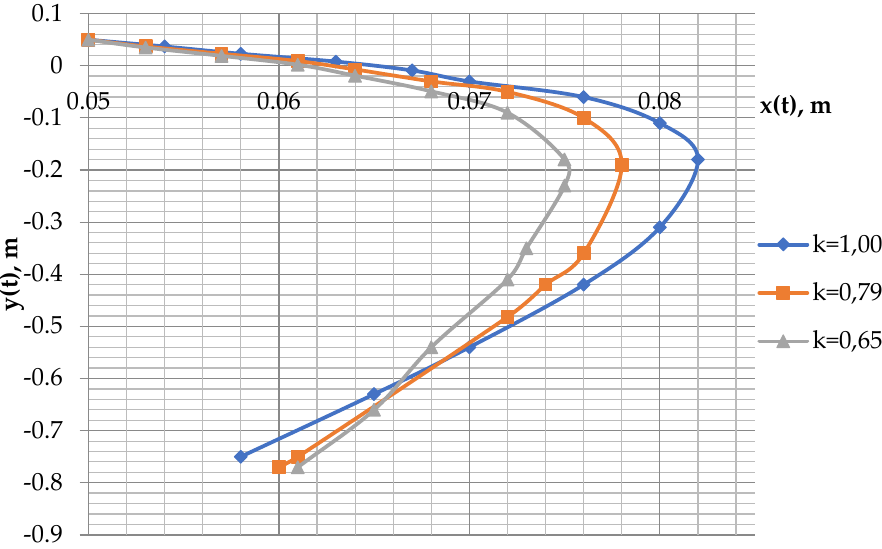
Figure 5. Dependence of particle motion at a rotation frequency of n = 3000 min − 1 .